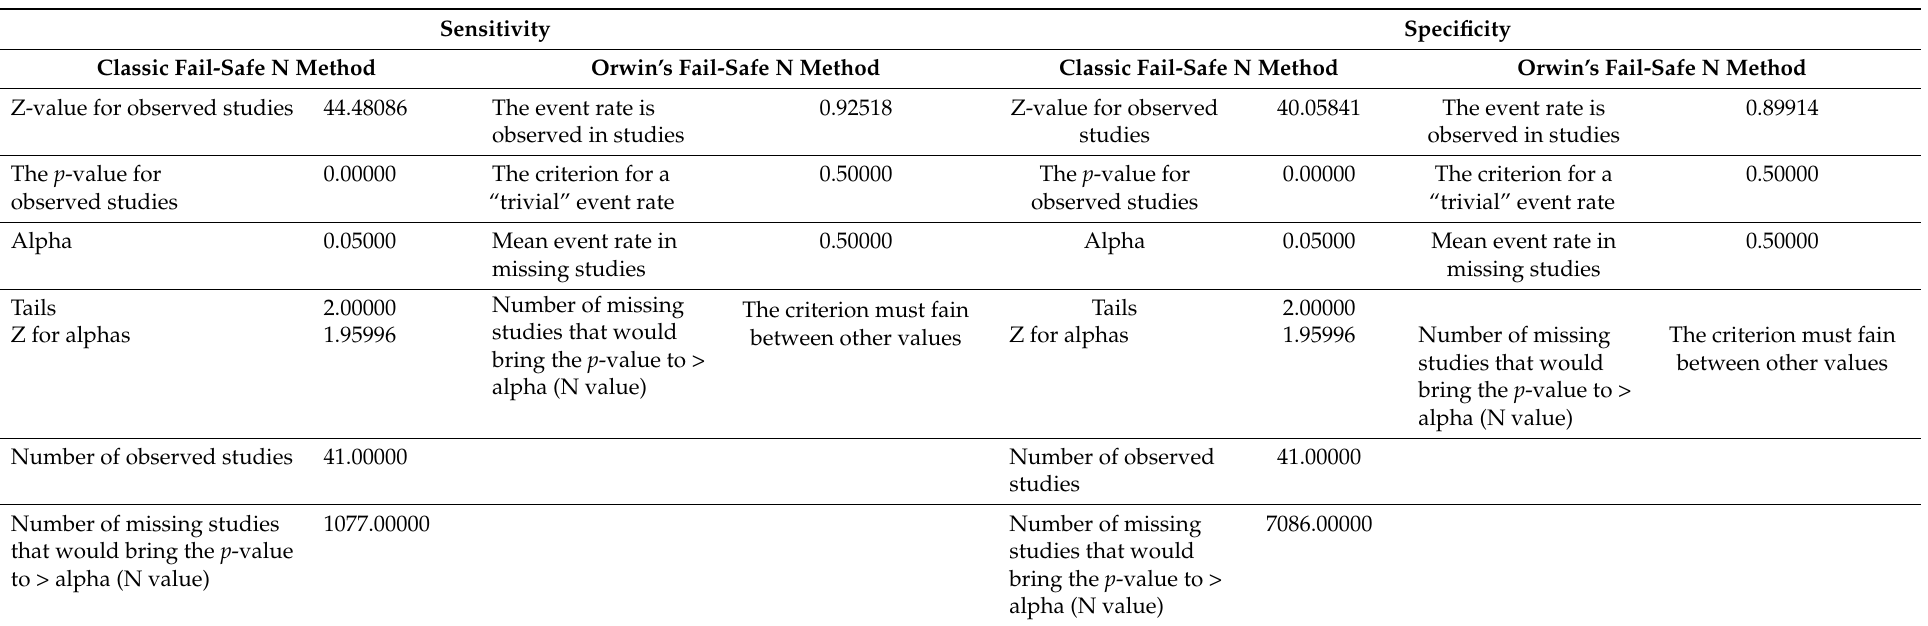
Table 3. Classic and Orwin’s Fail-Safe N